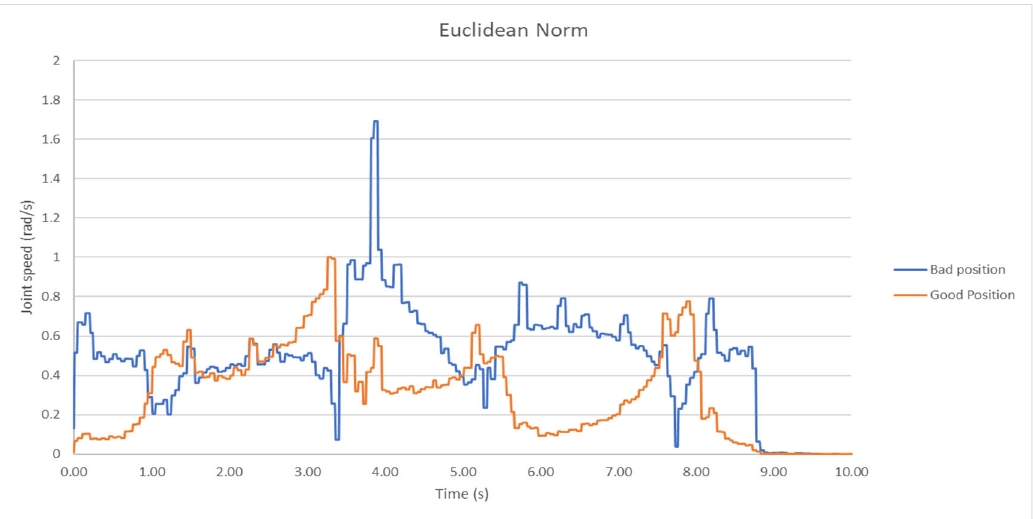
Figure 11. Joint velocities during the execution of the path ‐ following task for the optimal and “bad” task placements for end effector velocity 0.2 m/s.